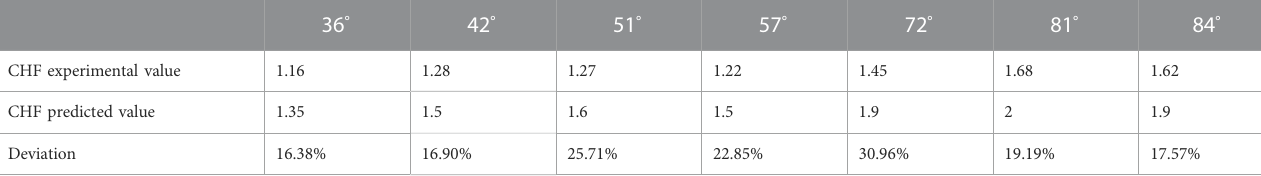
TABLE 2 Comparison of predicted and experimental values of CHF.